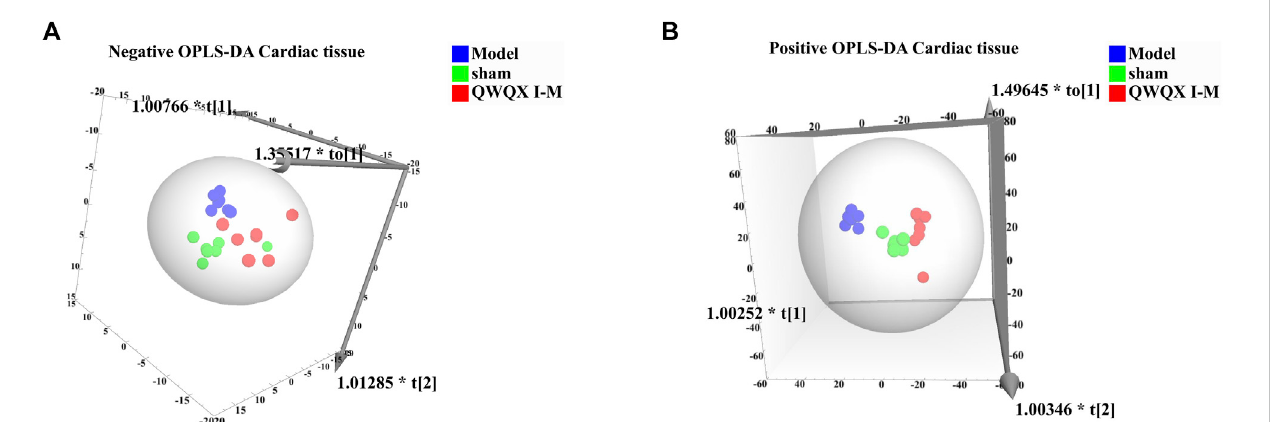
FIGURE 7 Cardiac tissue metabolomics OPLS-DA scores for each group of rats. (A) Negative mode of various rats. (B) Positive mode of various